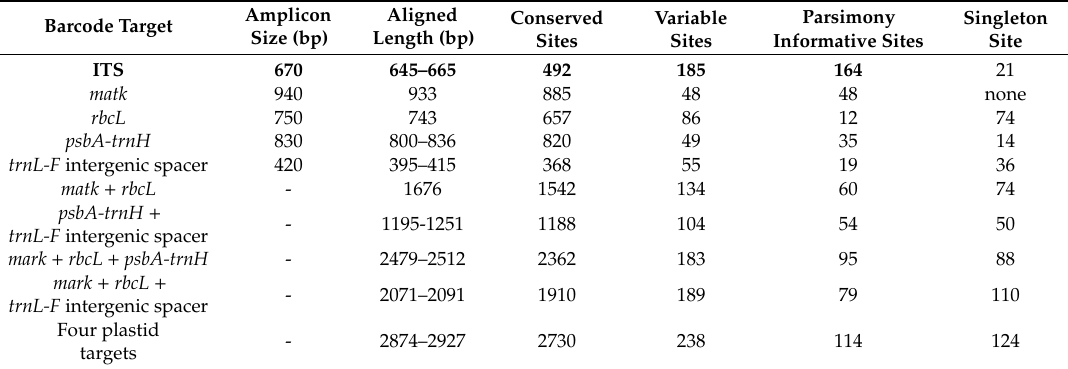
Table 3. Amplicon size of plastid loci and nuclear barcode region in Amomi Fructus and adulterants species and the sequence characteristics (single and in di ff erent multilocus